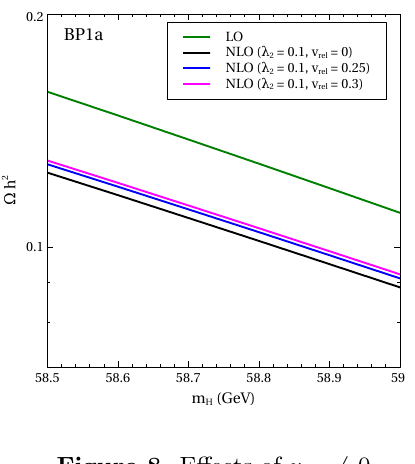
Figure 8 . E(cid:11)ects of v rel